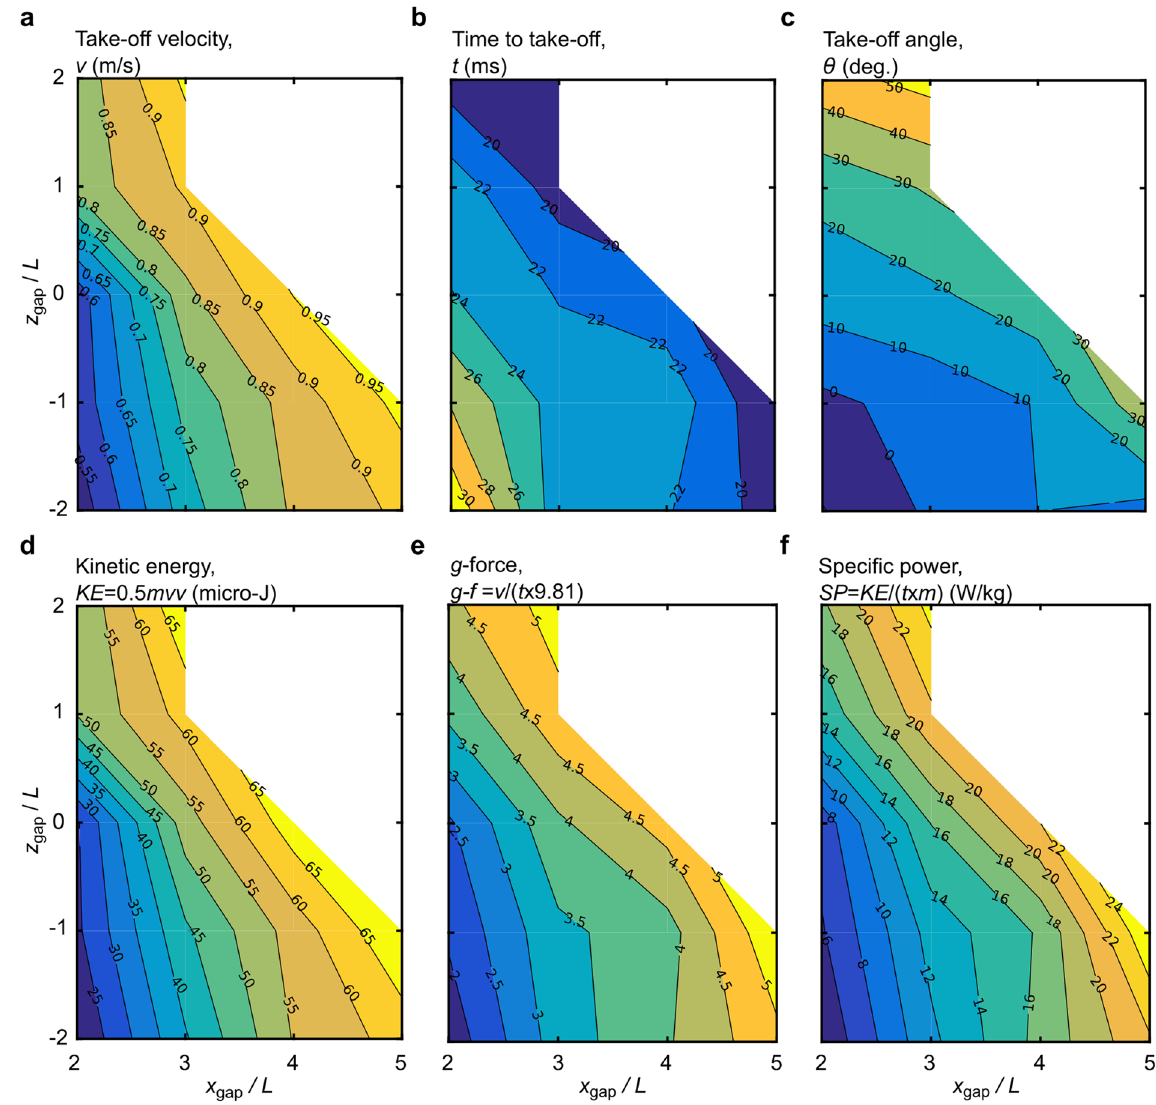
Figure 6. Contour plots of jumping characteristics of the Phidippus regius spider. ( a – c ) Main data extracted from the experiments: ( a ) The velocity magnitude at take-off, ( b ) time to take-off, and ( c ) trajectory angle at take-off. ( d – f ) Main jumping metrics used to assess the jumping performance: ( d ) Kinetic energy of the jump, ( e ) ratio of the jumping acceleration at take-off to gravitational acceleration ( g -force), and ( f ) specific power of the jump relative to the total body